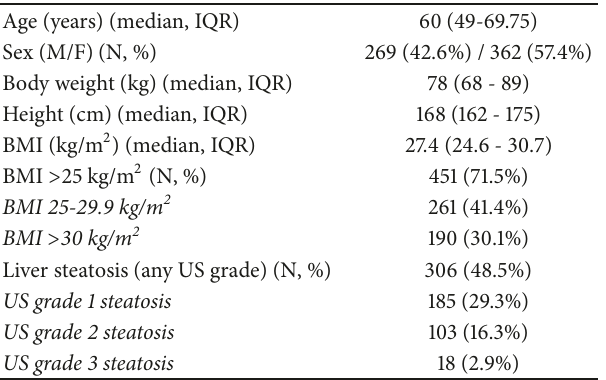
Table 1: Demographic and US findings of the entire examined cohort (N=631 patients).